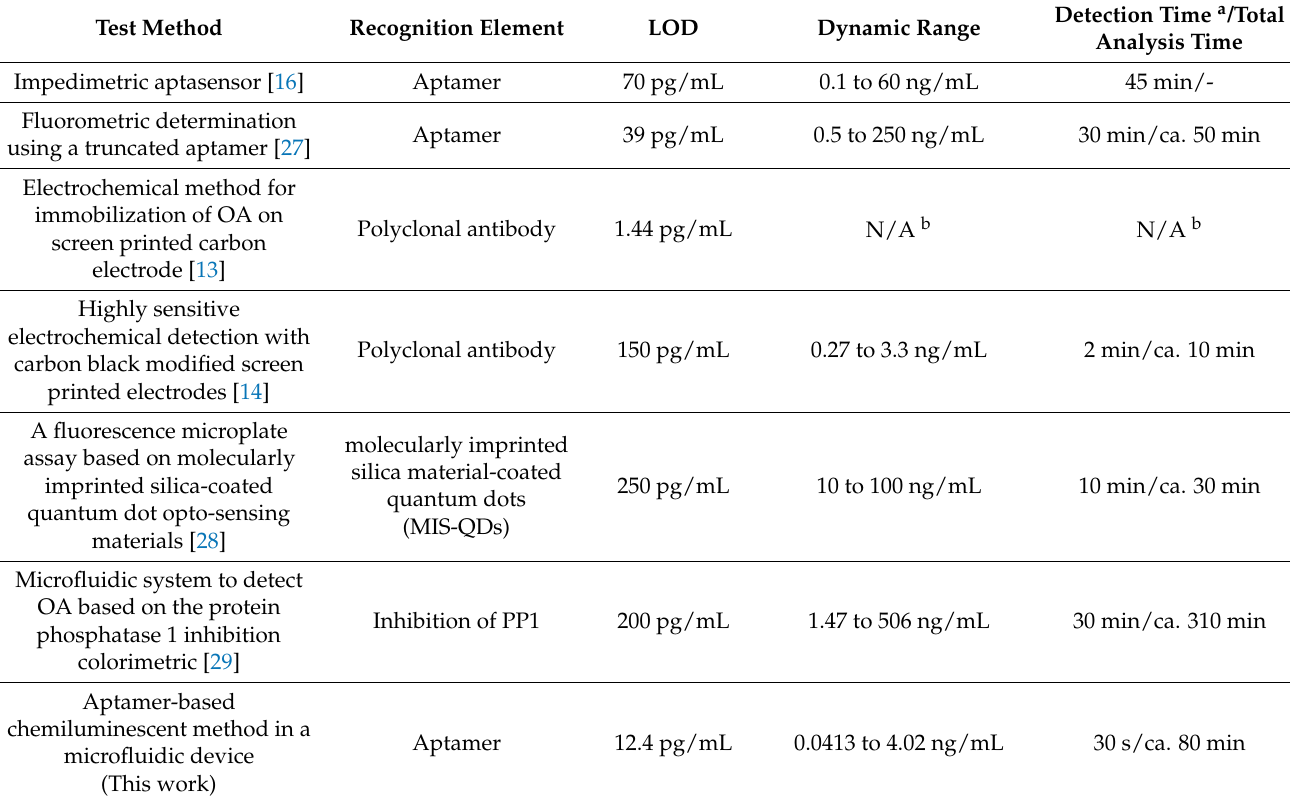
Table 1. Comparative table for the detection of OA using different methods.